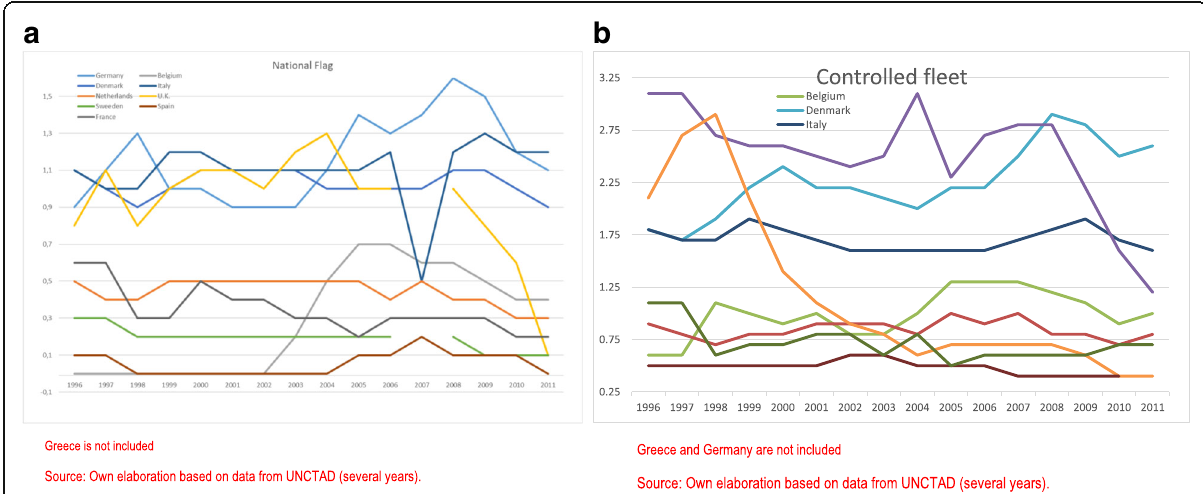
Fig. 2 a Trend in the share of the main EU maritime countries in the world fleet (national flag), 1996 – 2011 (in %). Greece is not included. Source: Own elaboration based on data from UNCTAD (several years). b Trend in the share of the main EU maritime countries in the world fleet (controlled fleet in DWT), 1996 – 2011 (in %). Greece and Germany are not included. Source: Own elaboration based on data from UNCTAD (several